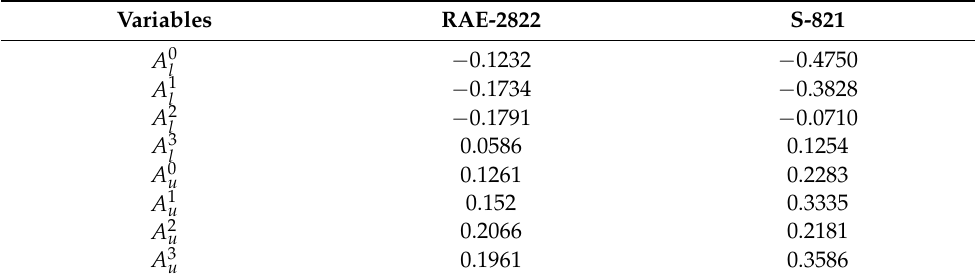
Table 4. The design variables for CST.